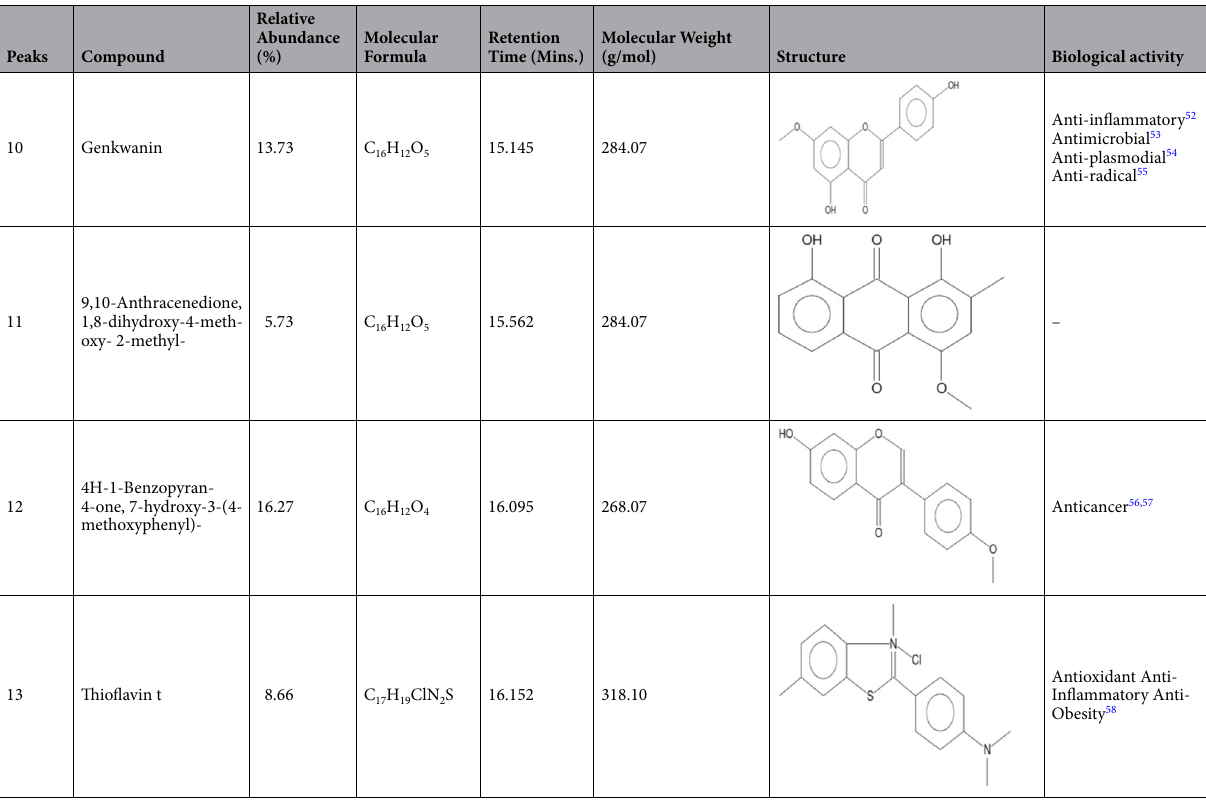
Table 6. Bioactive compounds identified in R. beninensis